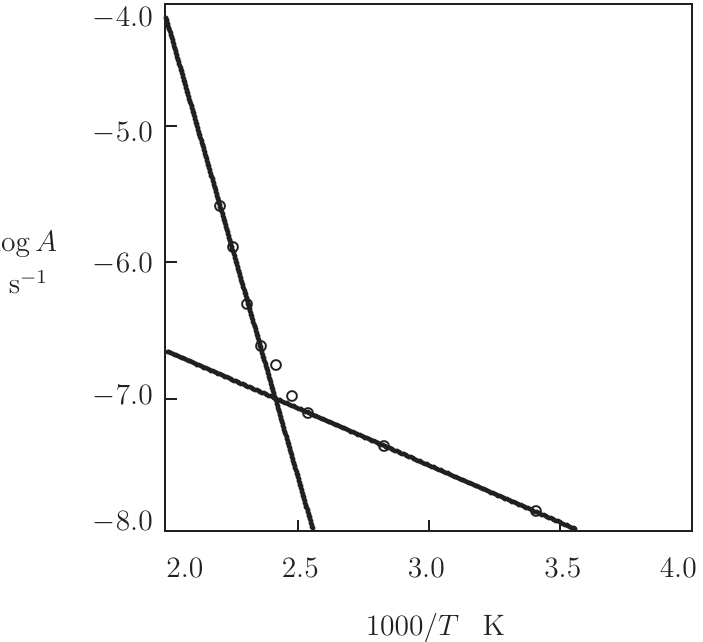
Figure 8. Coefficient A versus temperature T . Circles: treatment of observations in tensile tests. Solid lines: approximation of the data by Equation (7) with E a = 16.7 kJ/mol (low temperatures) and E a = 133.3 kJ/mol (high